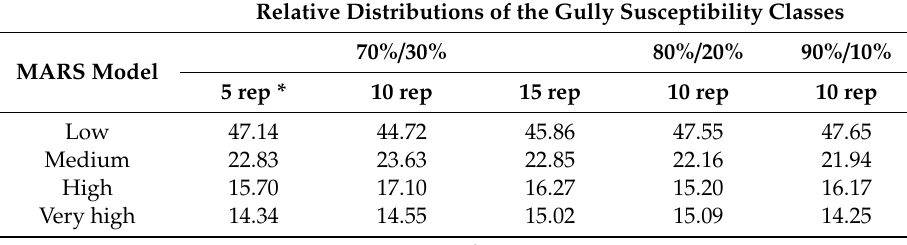
Table 3. Relative distributions of the gully susceptibility classes.